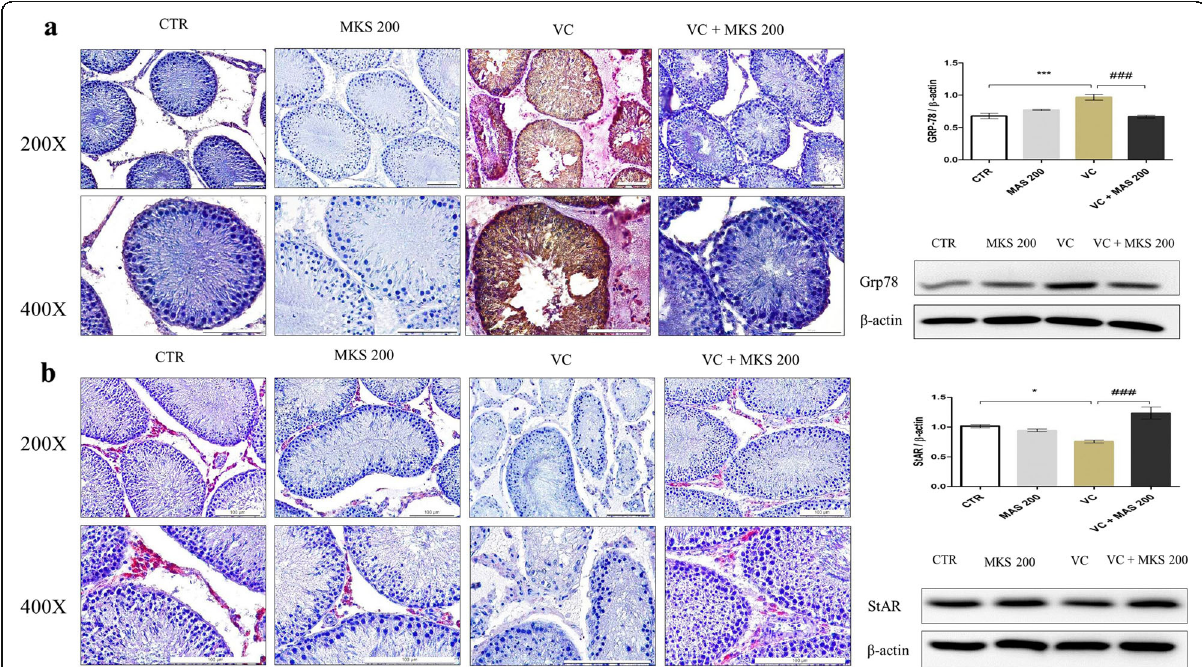
Fig. 2 Effect of MAS on testicular protein levels in varicocele (VC)-induced male SD rats determined by immunohistochemistry and western blot analysis. ( a ) Grp 78, ( b ) StAR. Data are presented as means ± SEM. The differences were tested by one-way ANOVA followed by Tukey ’ s post hoc test; n = 10 for each group. * Significant at P < 0.05; ** Significant at P < 0.01; *** Significant at P < 0.001- versus CTR group; # Significant at P < 0.05; ## Significant at P < 0.01; ### Significant at P < 0.001- versus VC group. CTR: control; MAS 200: MAS 200 mg/kg p.o.; VC: varicocele; VC + MAS 200: MAS 200 mg/kg p.o.; p.o.: per oral; ANOVA: analysis of variance; SEM: standard error of the